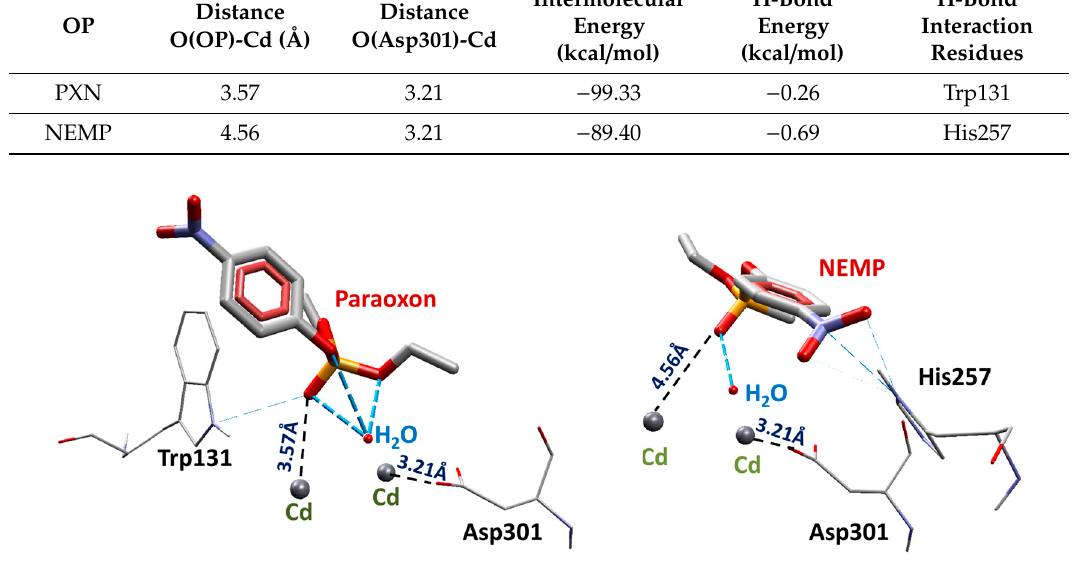
Figure 4. Best docking poses for PXN and NEMP.